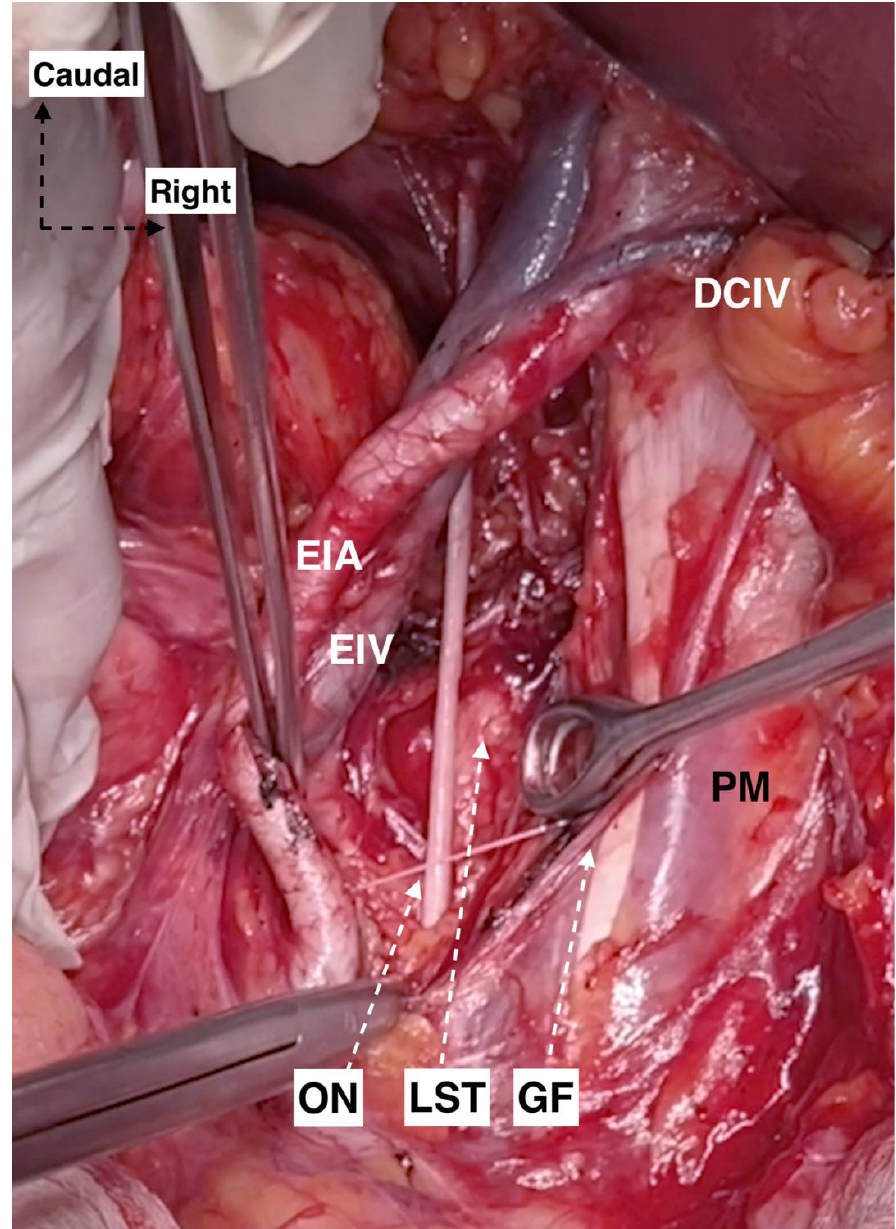
Figure 5. Avascular region of the right pelvic sidewall (surgical archive by Dr. Ilker Selcuk). DCIV: deep circumflex iliac vein; EIA: external iliac artery; EIV: external iliac vein; ON: obturator nerve; LST: lumbosacral trunk; GF: genitofemoral nerve; and PM: psoas major muscle. Step 2. Vascular Region